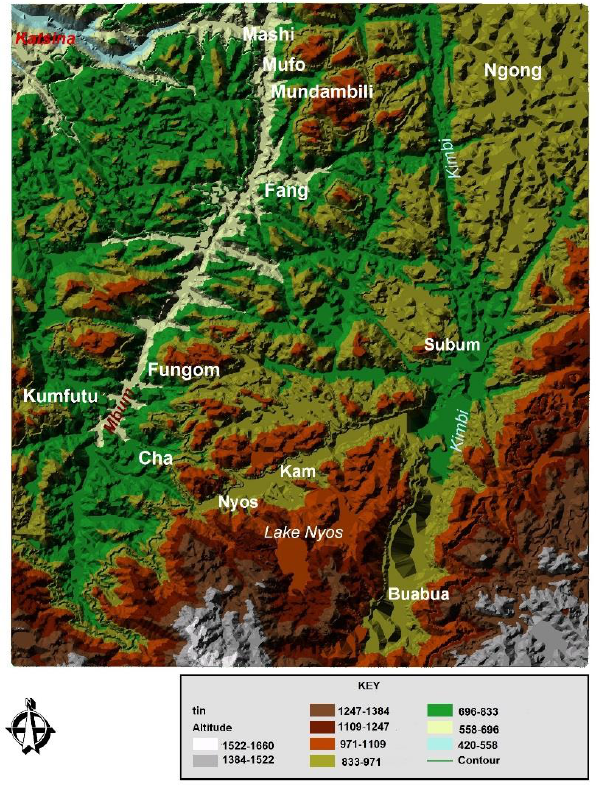
Figure 9. DEM of the Lake Nyos area colored as a function of elevation and set up by ArcGIS 10.0. It shows a highly fractured area with rivers Mbum, Kimbi and Katsina forming the main valley. The southern part of the map represents a horst while the Northern part is a graben. The area is criss-crossed by many fractures.